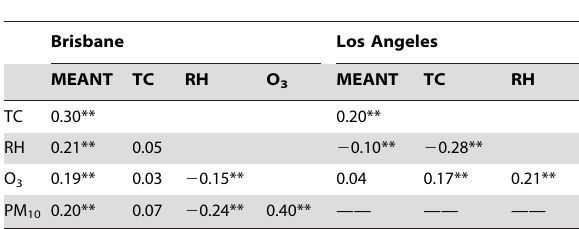
Table 2. Spearman’s correlation between daily weather conditions and air pollutants in Brisbane, Australia and Los Angeles, United